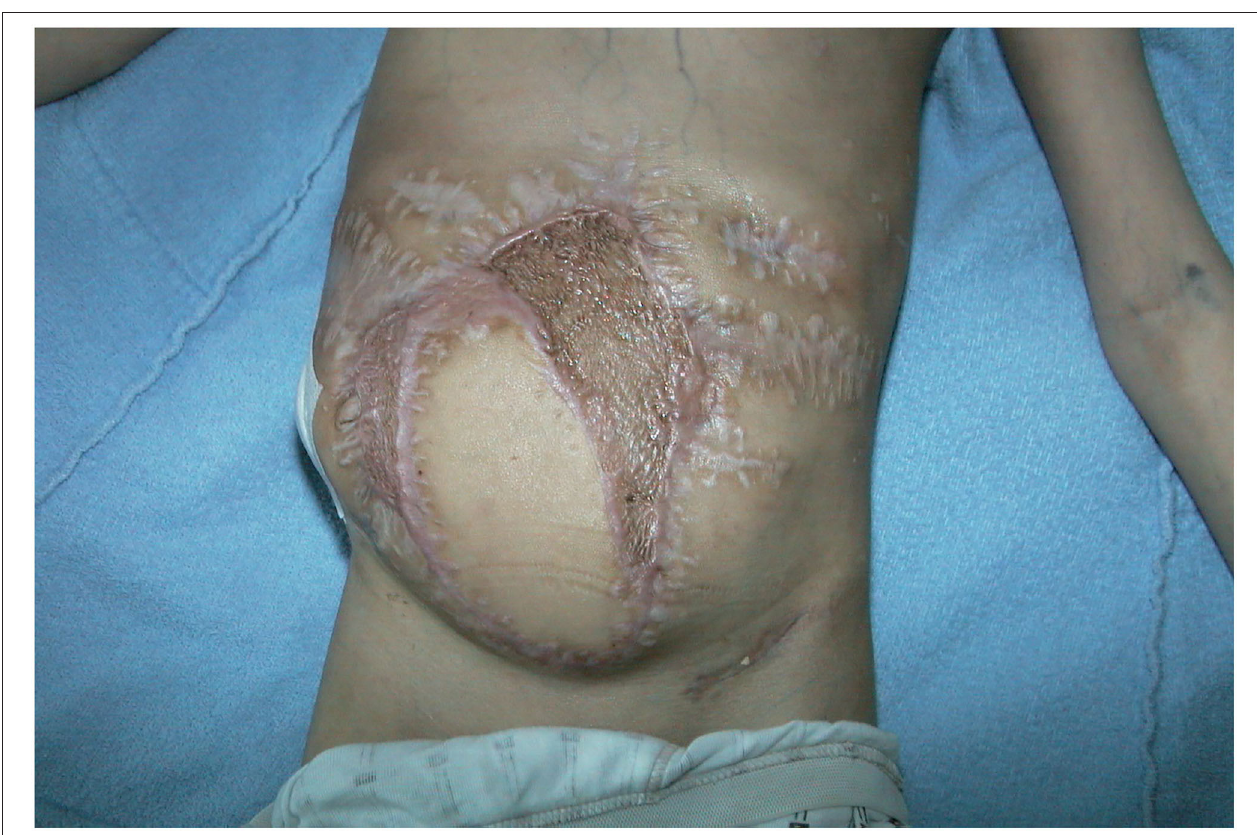
FIGURE 12 | Three months follow-up after LDM transfer without any wound healings problem at recipient